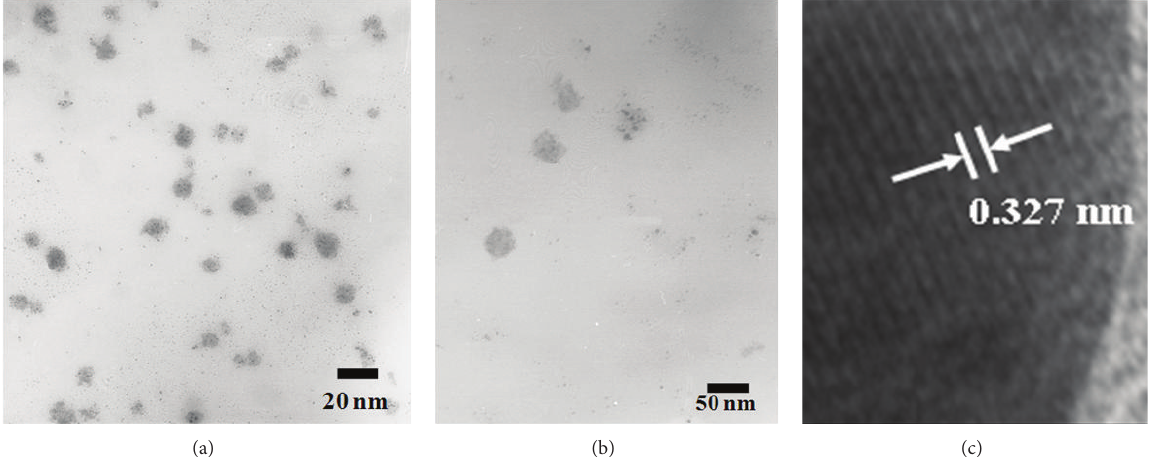
Figure 7: TEM micrographs of VO 2 (M) powder prepared by microwave irradiation power 300 W and calcination at temperature 500 ∘ C for